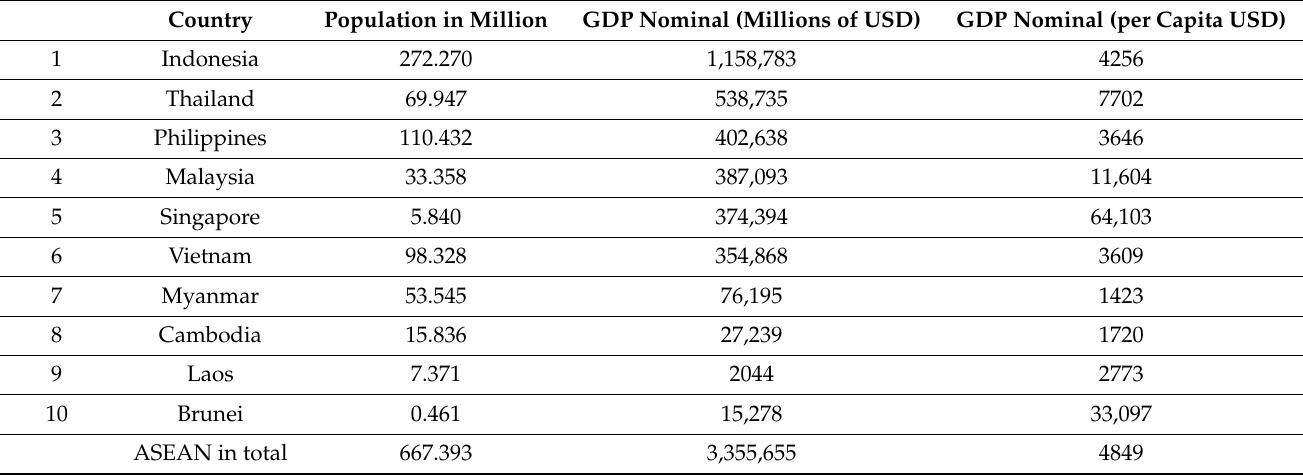
Table 2. GDP and GDP per capita in ASEAN countries in